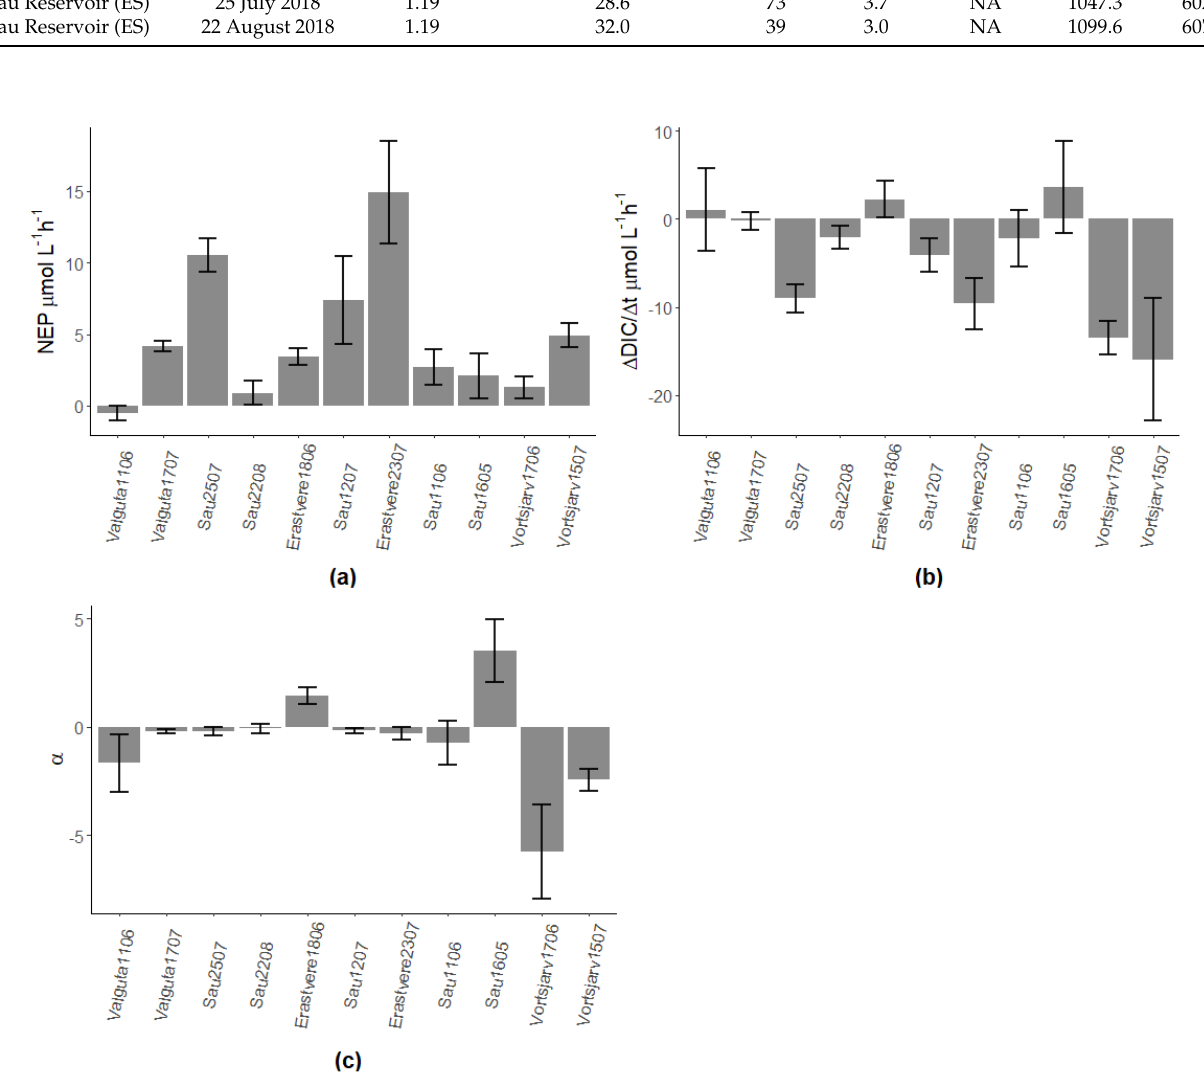
Figure A1. ( a ) NEP rates obtained from rates of change of oxygen (dDO/dt), ( b ) rates of change of DIC and ( c ) ratios between calcification and NEP ( α ). Numbers after the name of lakes represent the day and month of sampling; all lakes were sampled in 2019 except for Sau Reservoir in 2018.